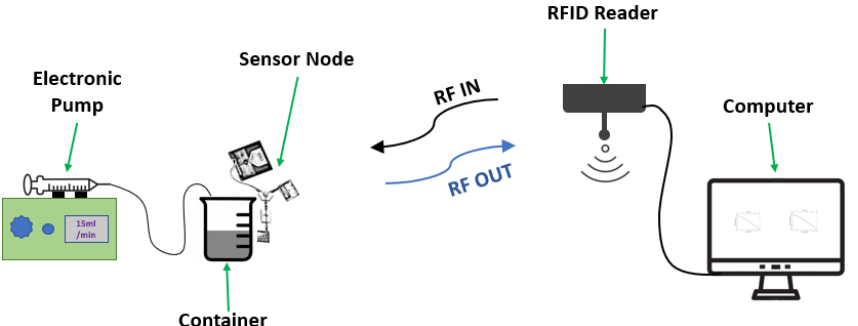
Figure 1. Demonstration of the proposed wireless liquid-level measurement